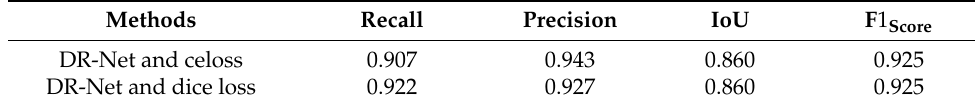
Table 1. Accuracy of DR-Net with different loss functions.